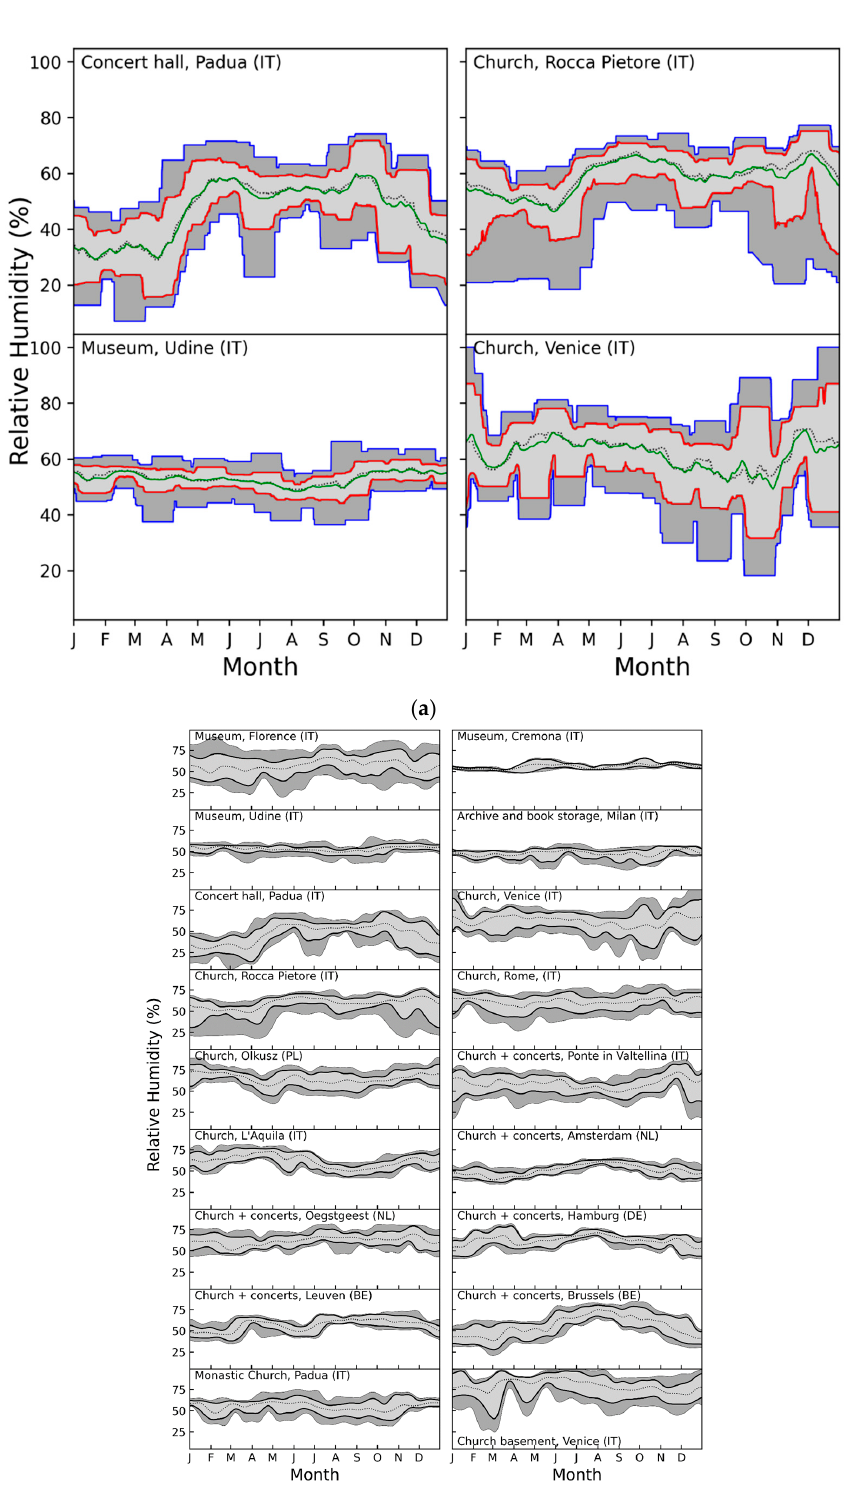
Figure 4. ( a ) Comparison between the CMA method suggested in the Annex A (represented with contour lines, i.e.,: blue: 0-ile and 100-ile, red: 7-ile, 93-ile; green: mean), and the IPD method (represented with bands, i.e., light grey: safe band; dark grey: risky band; dotted line: median, i.e., 50-ile). Lines and bands are calculated as moving average, or moving bins, with a 30-day time window. ( b ) Safe band (light grey) and risky band (dark grey) of all the case studies to which smoothing has been